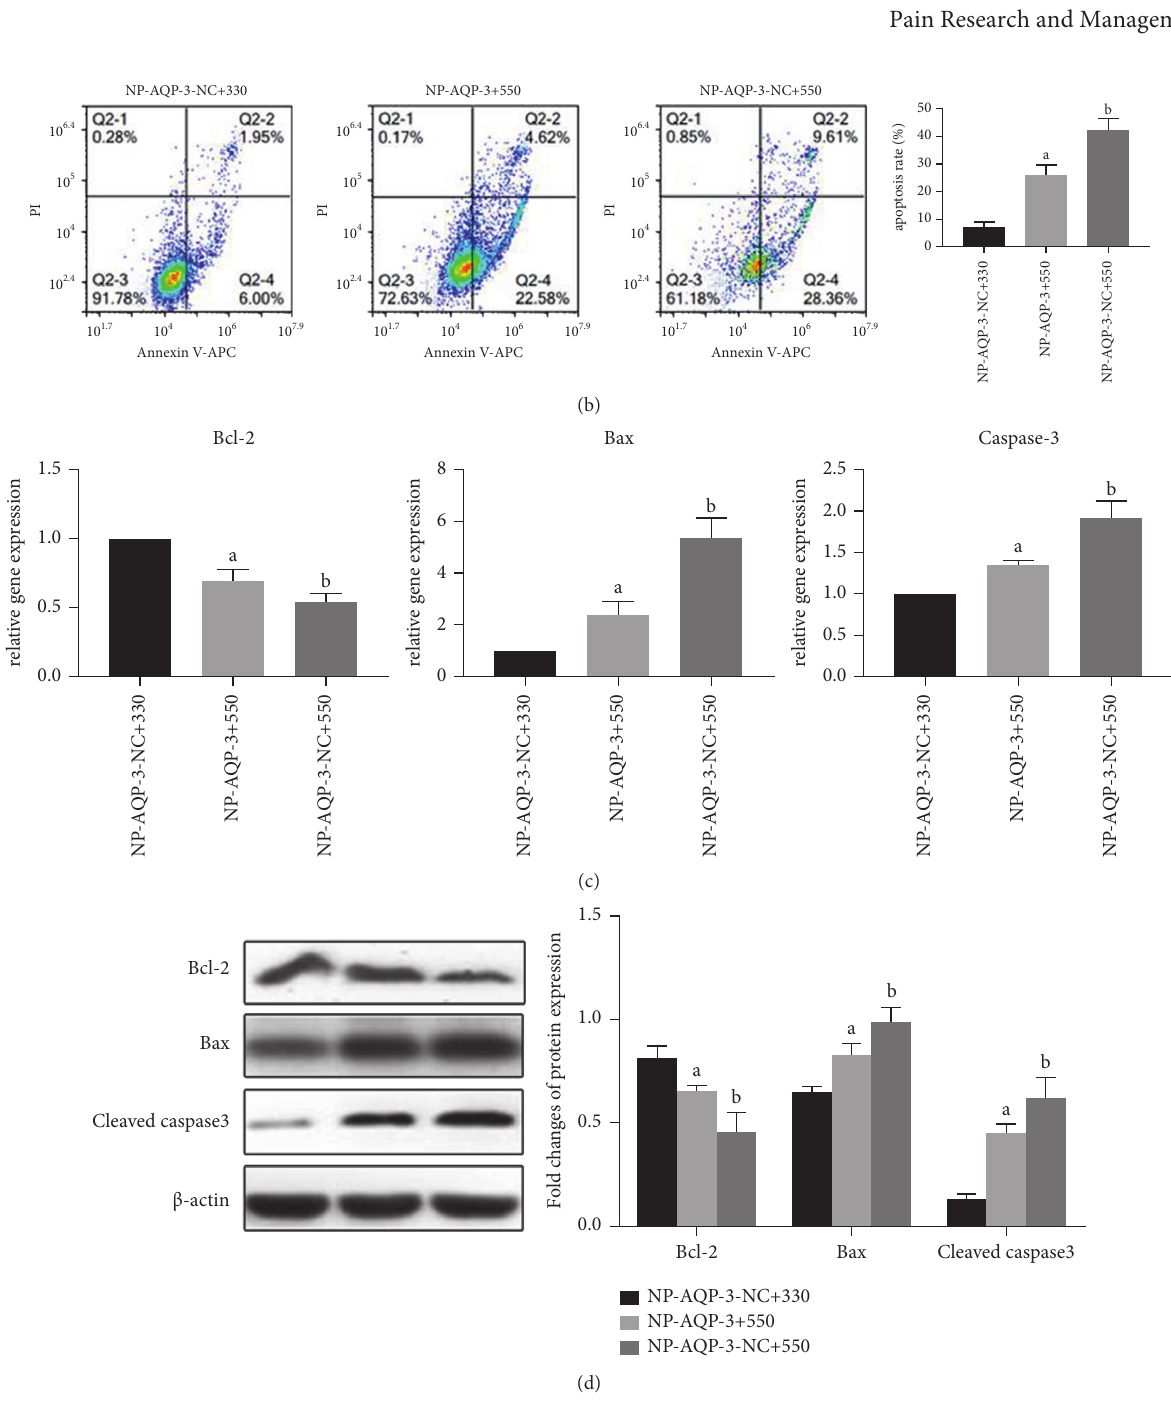
Figure 5: AQP-3 overexpression promoted activation of ERK1/2 signaling and alleviated hyperosmolarity-induced apoptosis. (a) Western blotting analysis of ERK1/2 and p-ERK1/2 expression in AQP-3 overexpressed NP cells under a hyperosmolarity (550mOsm/kg). (b) Flowcytometry analysis of NP cell apoptosis ratio. (c) and (d): real-time PCR and western blotting analysis of proapoptosis (Bax and caspase 3/cleaved caspase 3) and antiapoptosis (Bcl-2) molecules under different osmotic pressures (330 mOsm/kg and 550mOsm/kg), respectively. NP-AQP-3+ 330: AQP3 overexpressed NP cells cultured in 330mOsm/kg. NP-AQP-3 +550: AQP3 overexpressed NP cells cultured in 550mOsm/kg. NP-AQP-3-NC+550: NP cells without transfection (NP-CN) cultured in 550 mOsm/kg. Data are expressed as mean ± SD. (A) indicates a significant difference ( p < 0 . 05) when compared with the group of NP-AQP-3 +330. (B) indicates a significant